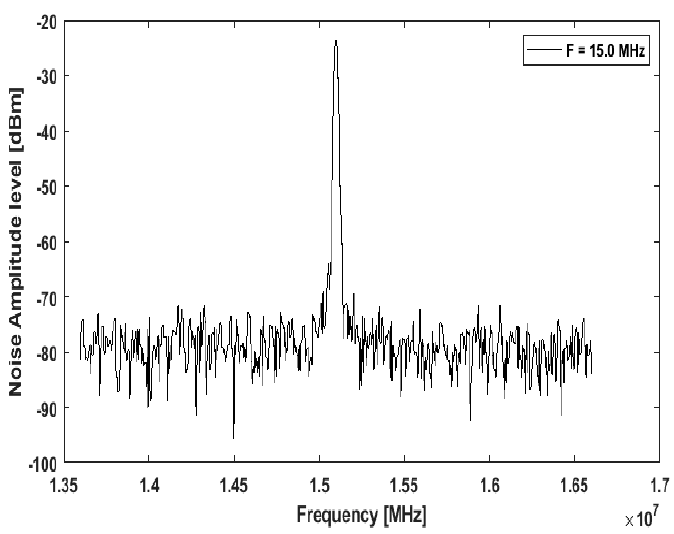
Figure 12. Waveform at 12 MHz.